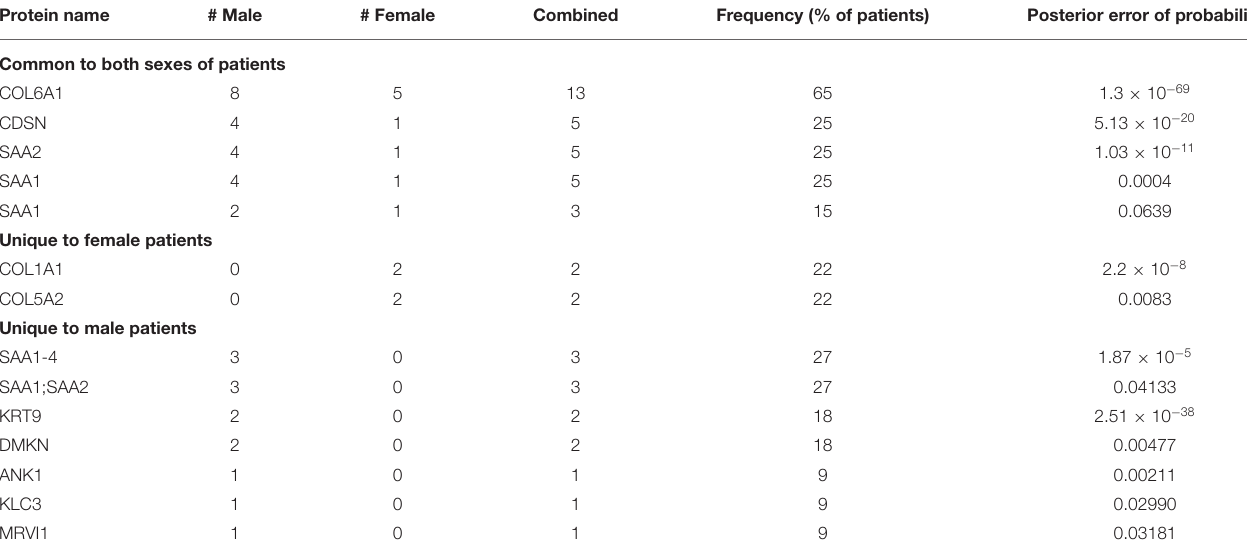
TABLE 1 | Patient-unique peptides grouped as common to both sexes, or specific to sex, and ranked by frequency (peptide sequences are found in Supplemental Material ). Protein name